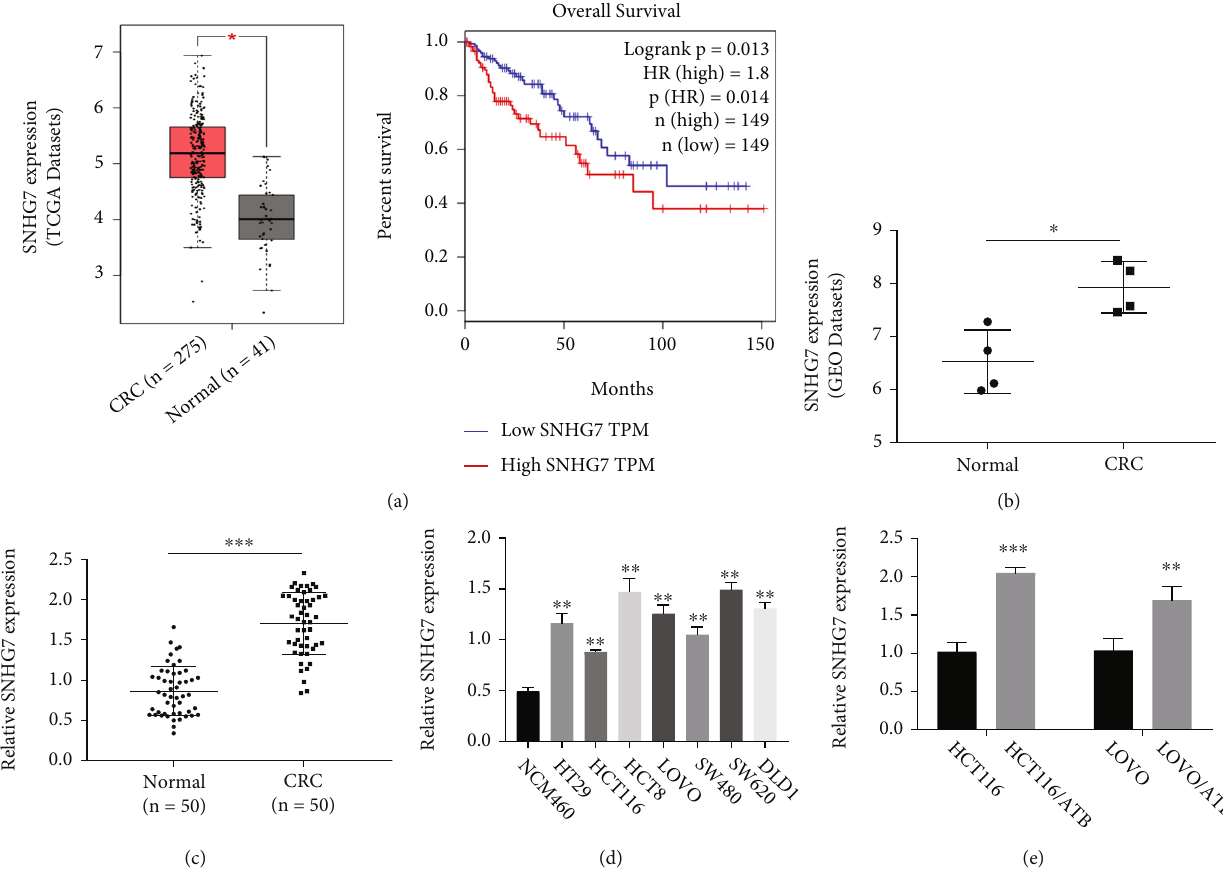
Figure 1: The expression of SNHG7 is upregulated in CRC. (a) Gene expression pro fi ling interactive analysis (GEPIA) of the TCGA data to assess SNHG7 expression in rectal cancer (red column). (b) SNHG7 expression in the GEO dataset GSE75970. (c) qRT-PCR measurement to check the expression level of SNHG7 in 50 pairs of CRCs and the paracancerous tissues. (d) qRT-PCR analysis to determine the expression level of SNHG7 in CRC cell lines, HT29, HCT116, HCT8, LOVO, SW480, SW620, and DLD1 as well as in the normal cell line NCM460. (e) qRT-PCR analysis to detect SNHG7 expression in ATB-resistant cell lines HCT116/ATB and LOVO/ATB. The statistical signi fi cance of di ff erences was evaluated by Student ’ s t -test (* P < 0 : 05 , ** P < 0 : 01 , and *** P < 0 : 001